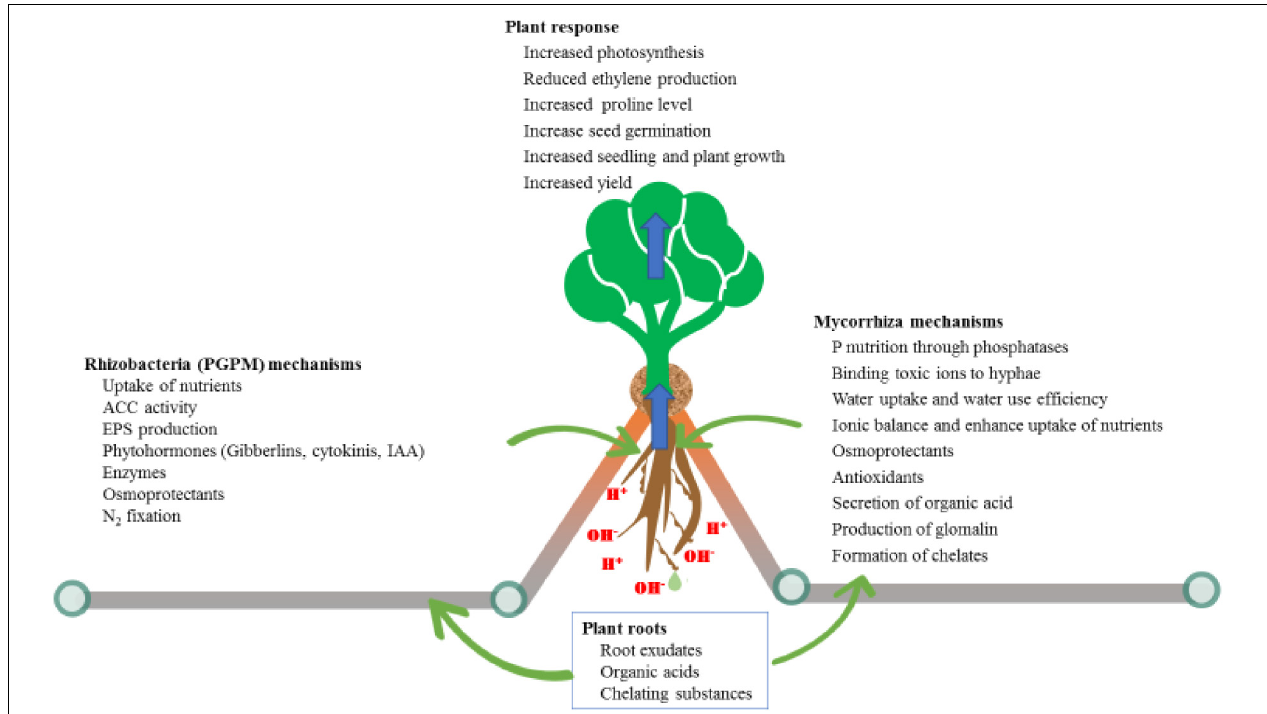
FIGURE 2 | Differences in mechanisms used by microbes (fungal versus bacterial) to alleviate different environmental stressors.